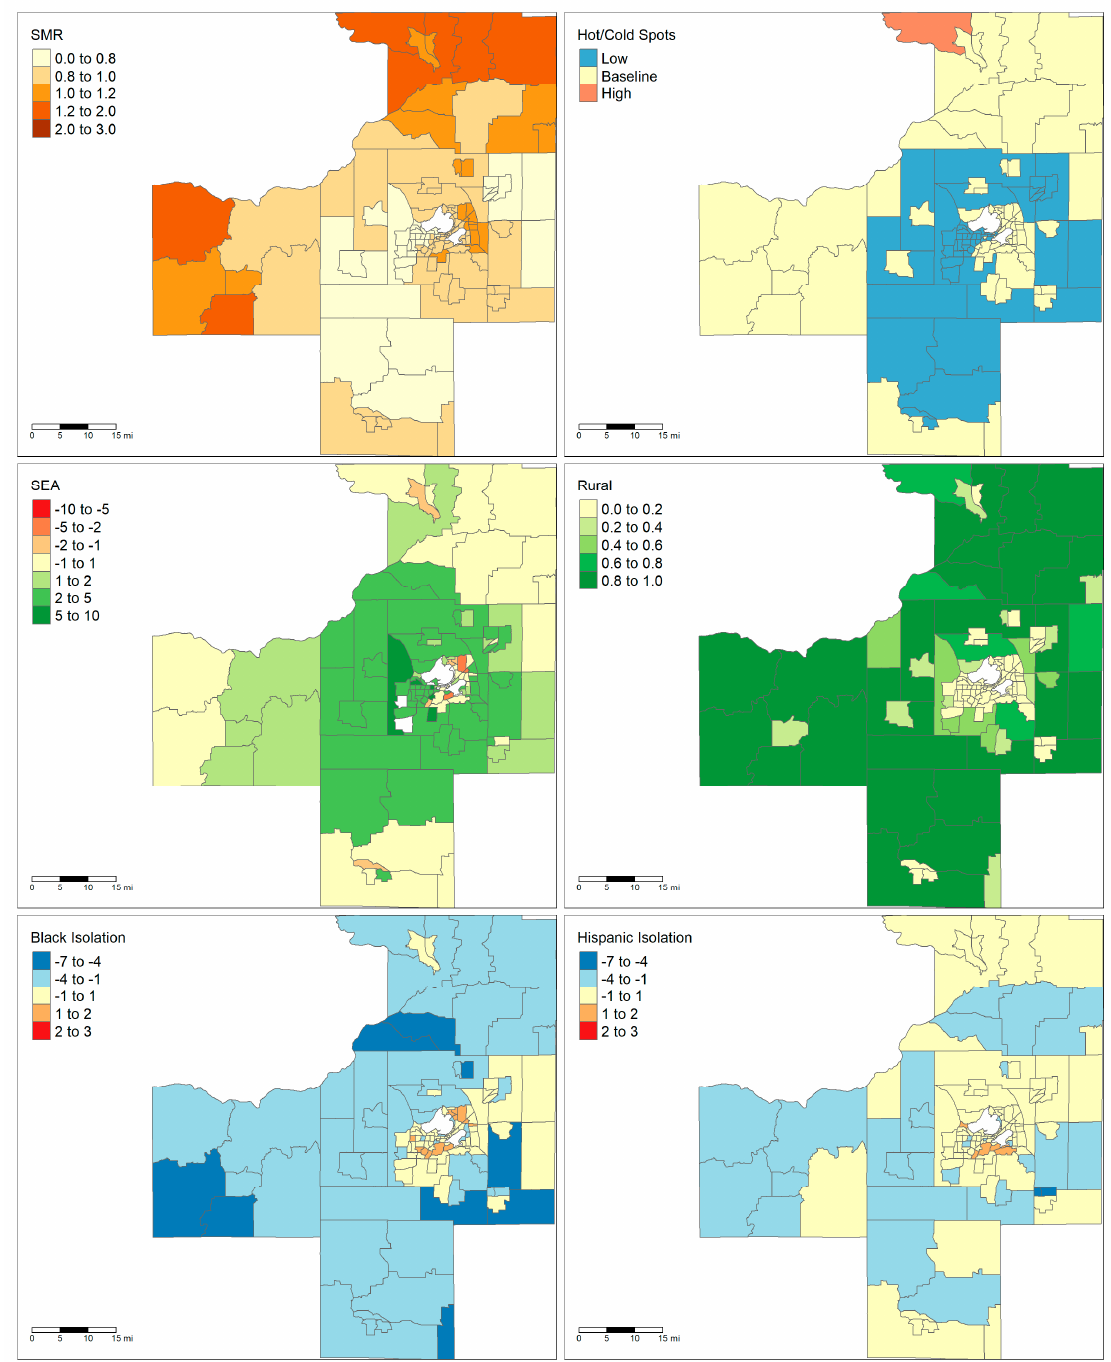
Figure 1. Maps of Madison, WI MSA. Upper left: liver cancer SMRs. Upper right: high- and low-mortality clusters of liver cancer. Middle left: socioeconomic advantage index with white tracts indicating areas whose ACS errors were outliers. Middle right: rurality. Lower left: Black local isolation scores. Lower right: Hispanic local isolation scores. Abbreviations: WI: Wisconsin, SMR: Standardized Mortality Rate, ACS: American Community Survey.